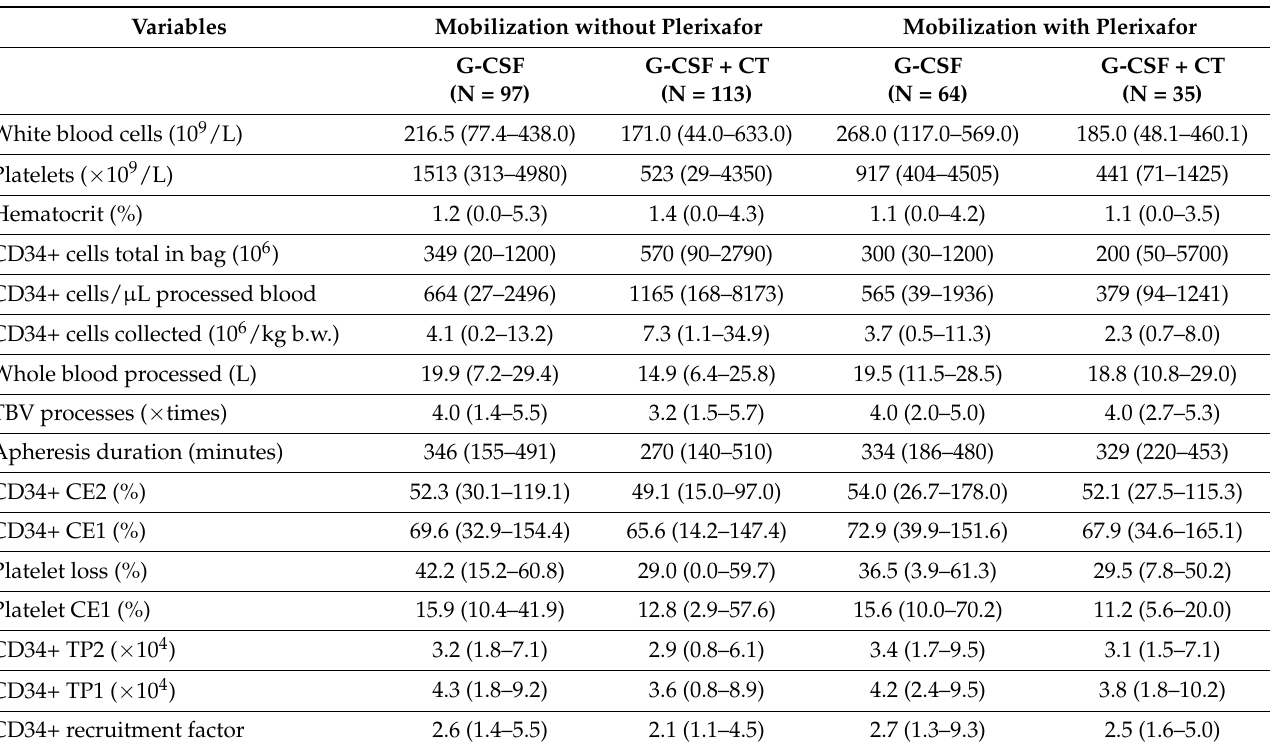
Table 3. Product characteristics and performance specifications for the Spectra Optia ® continuous mononuclear cell collection protocol by type of mobilization